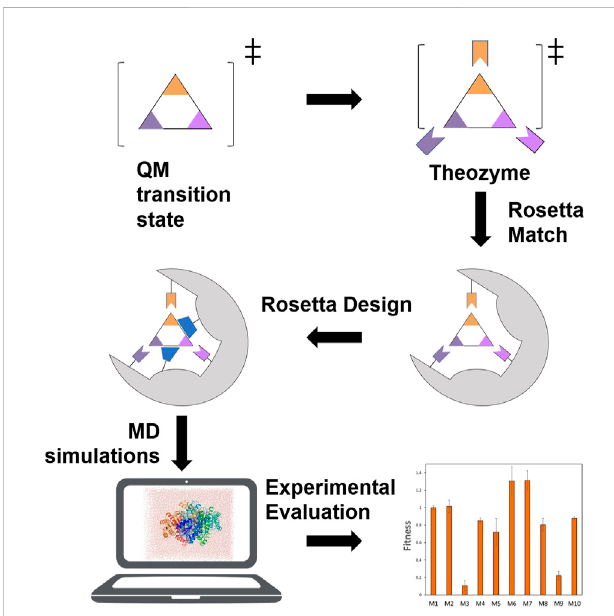
FIGURE 6 A representation of an enzyme in silico design protocol. The full steps including calculation of the theozyme model, insertion of the reaction transition state into a protein scaffold, Rosetta design to optimize the sequence of the enzyme, MD simulations for virtual screening and experimental